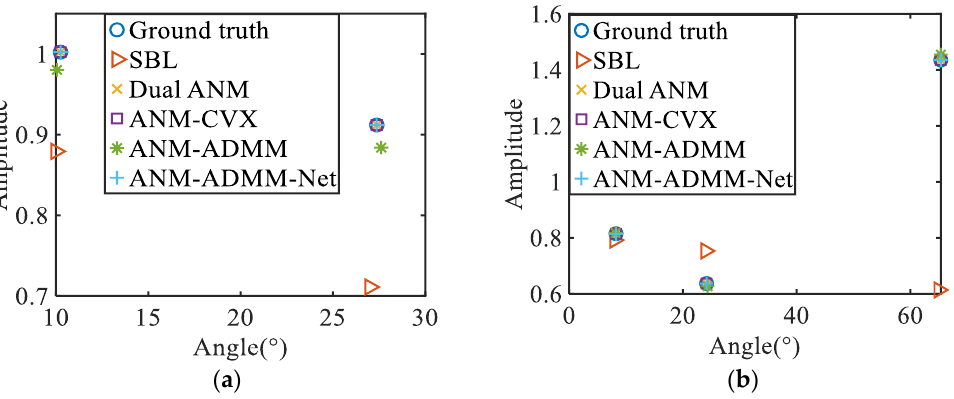
Figure 6. DOA estimation results of different methods. ( a ) Two targets. ( b ) Three targets.